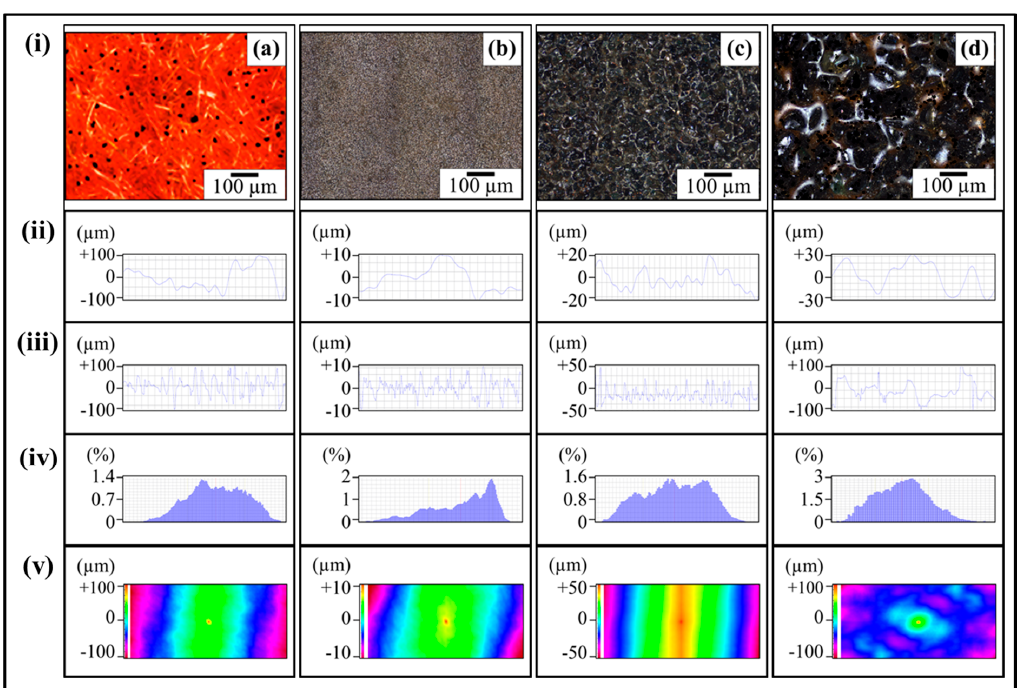
Figure 3. Surface roughness parameters of abrasive papers.